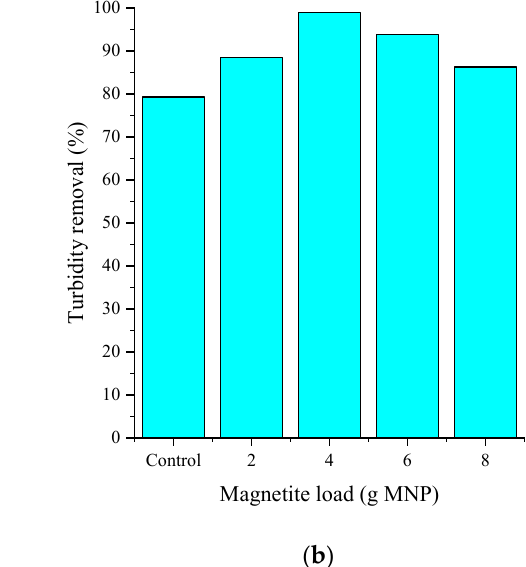
Figure 5. Comparison of the quality of biogas produced with and without magnetite for the same stream of wastewater.